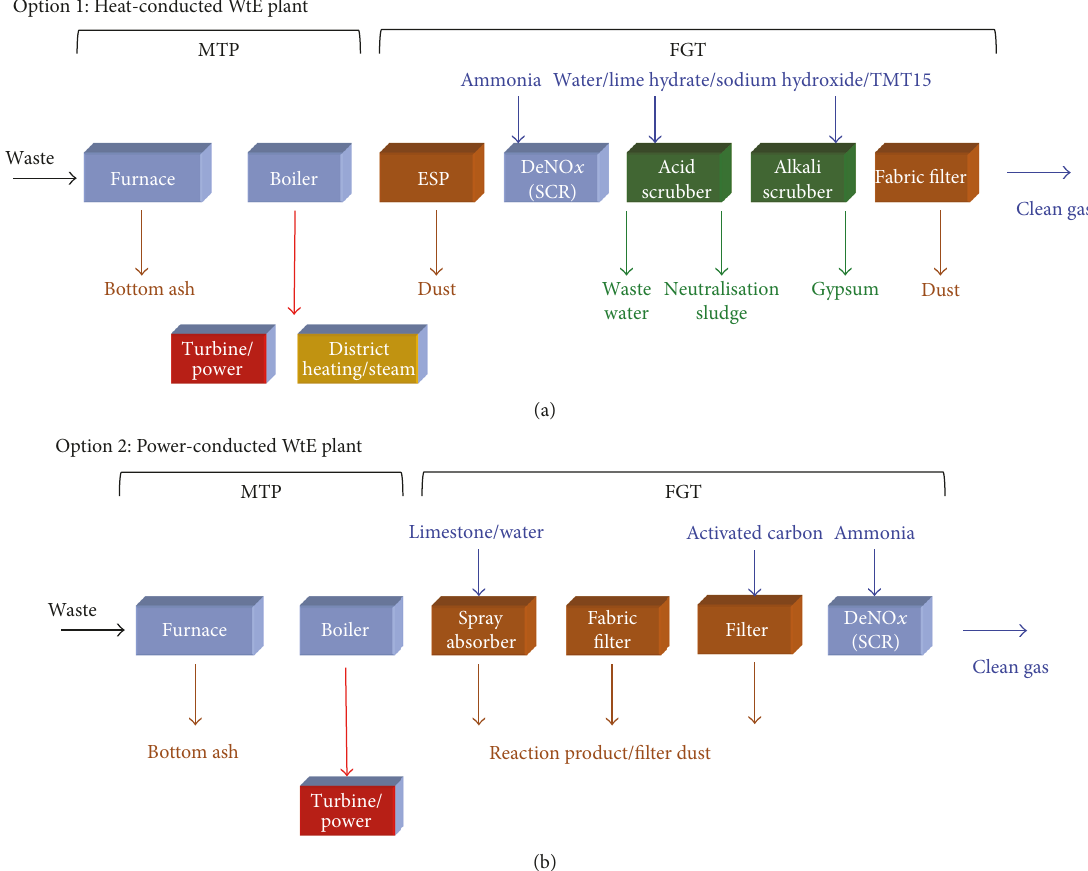
Figure 4: Summarized representation of both processes: (a) heat-conducted WtE plant with wet flue gas cleaning (option 1); (b) power- conducted WtE plant with dry flue gas cleaning (option 2). MTP: main thermal process, FGT: flue gas treatment, and ESP: electrostatic